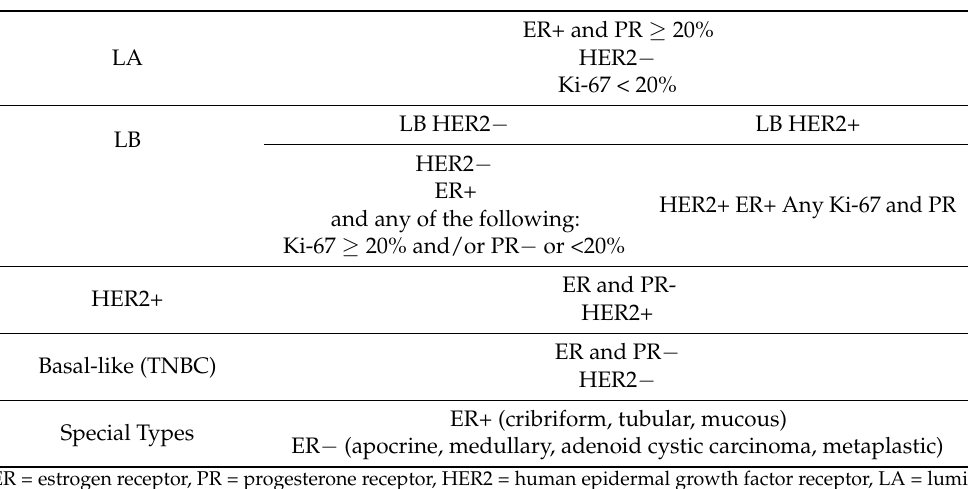
Table 3. Molecular classification of breast